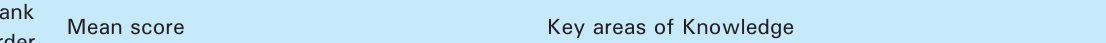
Key areas of Knowledge